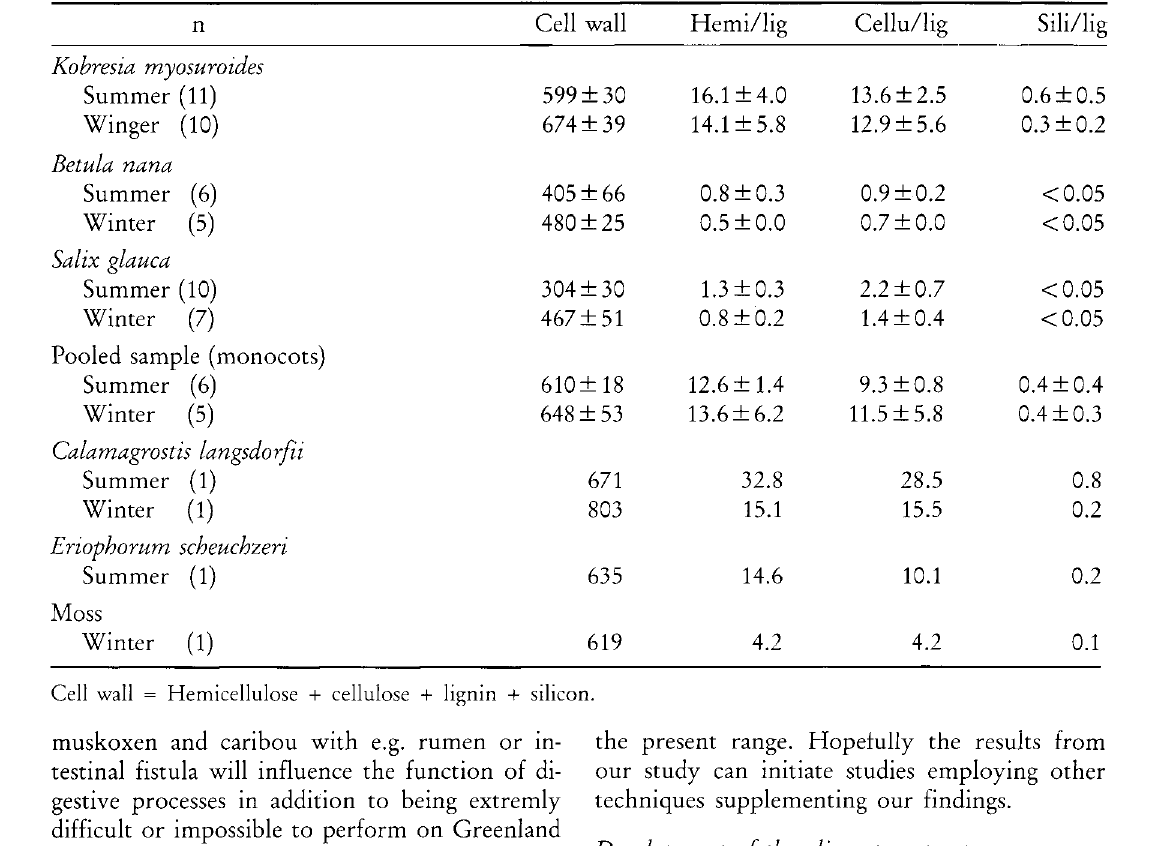
Table 4b. Chemical composition of important food plants from West Greenland, (g/kg dry matter ± S.D.). n